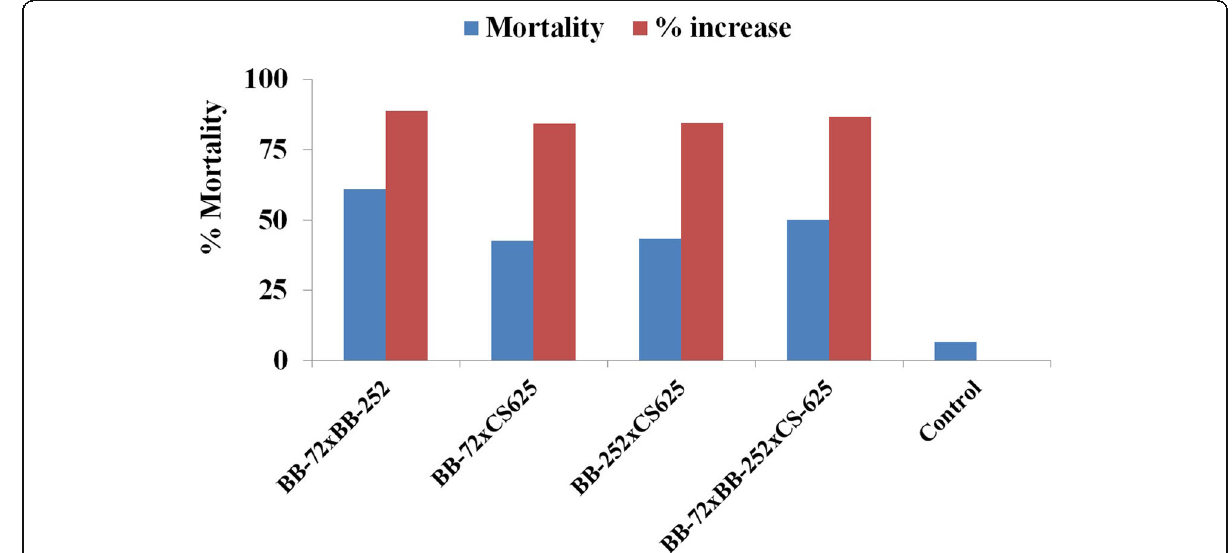
Fig. 4 Combined effects of fungal isolates on Myzus persicae